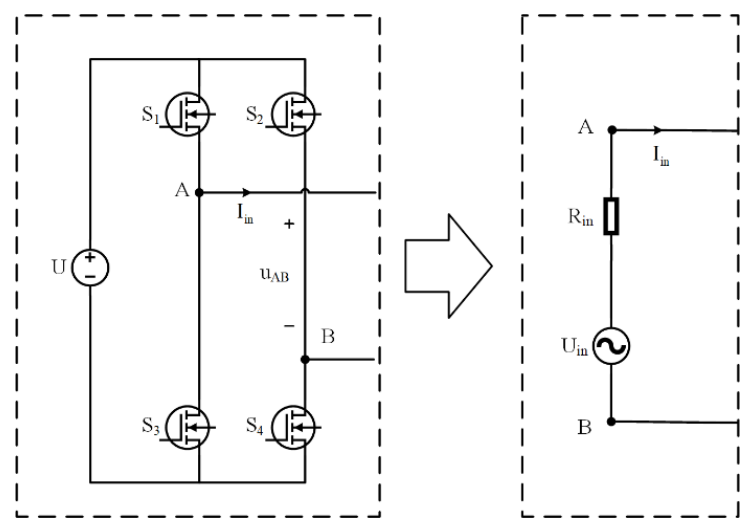
Figure 3. Equivalent circuit, focusing on the inverter circuit of the primary side. U in is the AC voltage source of U transformed by the inverter circuit, and R in is the equivalent internal resistance of U in . After using the same method, we obtain the equivalent circuit of the rectifier circuit after point a and point b on the secondary side in Figure 4.